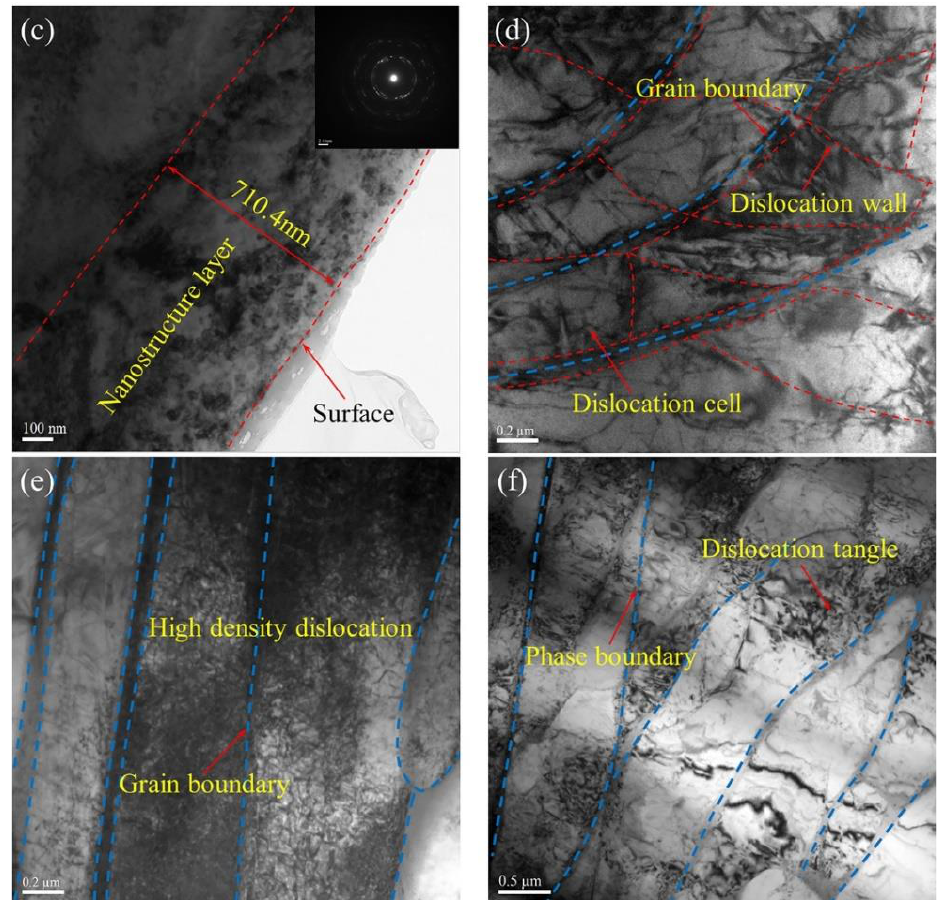
Figure 12. Transmission electron microscopy (TEM) morphology of the microstructure in the surface region of the LSP-treated Ti-6Al-4V titanium specimen: ( a ) surface nanocrystals; ( b ) high-resolution image of ( a ) showing different nanocrystal orientation; ( c ) nanocrystal layer; ( d ) dislocation cells; ( e ) high-density dislocations; ( f ) low-density dislocations. Reprinted with permission from Ref. [7]. Copyright 2022